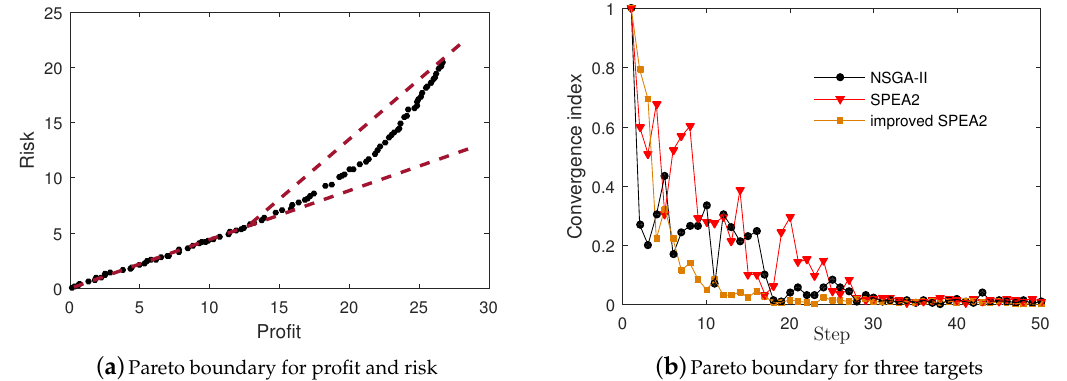
Figure 4. Pareto boundary for investment decision-making.